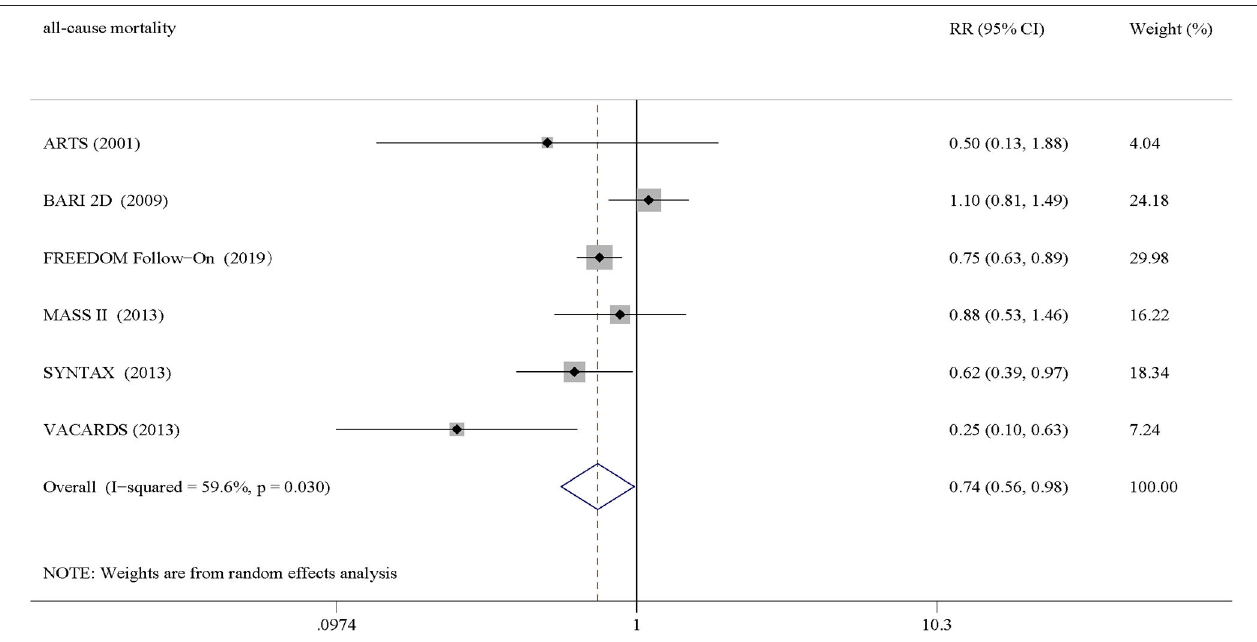
FIGURE 2 | Pooled results of all-cause